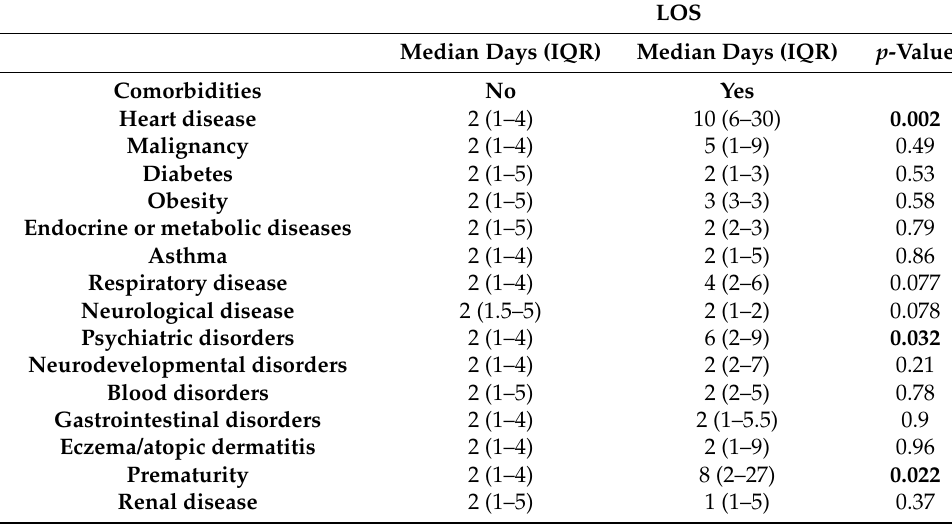
Table 3. Association of various comorbidities with influenza-related